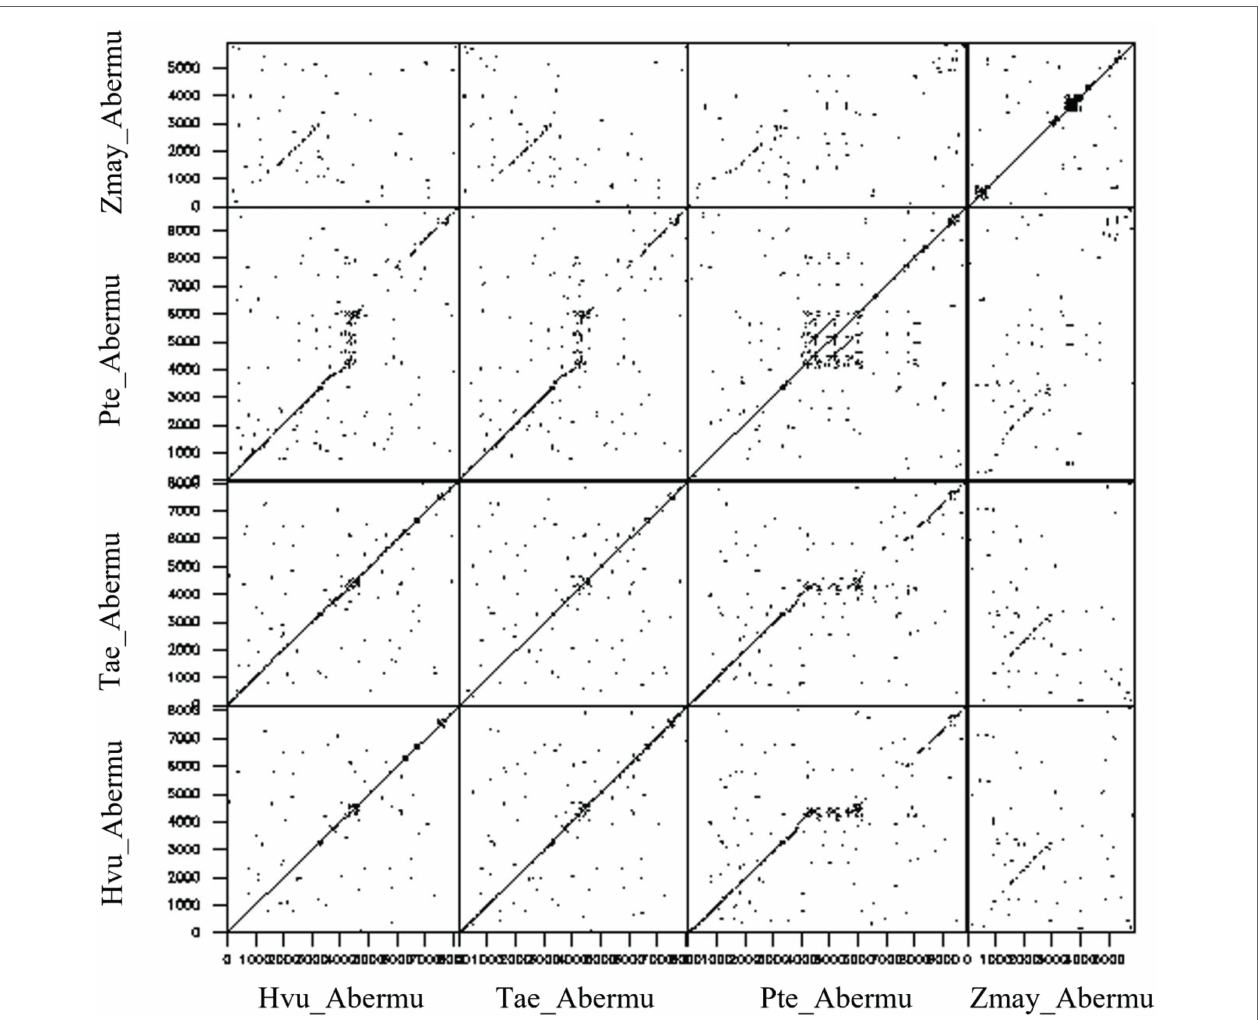
FIGURE 4 | Dotplot analysis between Hvu_Abermu and three other Abermu transposons in bread wheat, Puccinellia tenuiflora and maize.